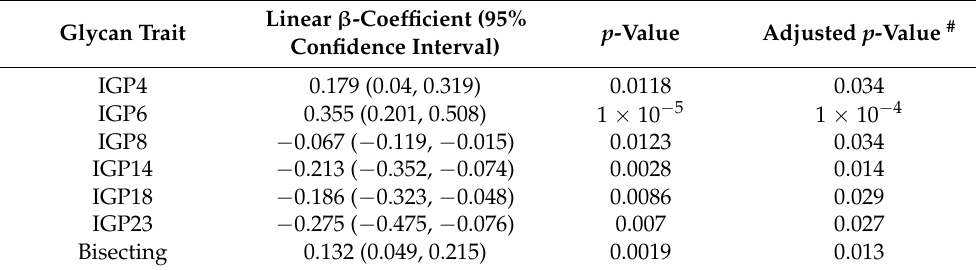
Table 4. Associations of IgG N -glycans with the CHA 2 DS 2 -VASc score corrected for age and sex. Only statistically significant traits and N -glycan structures are shown in the